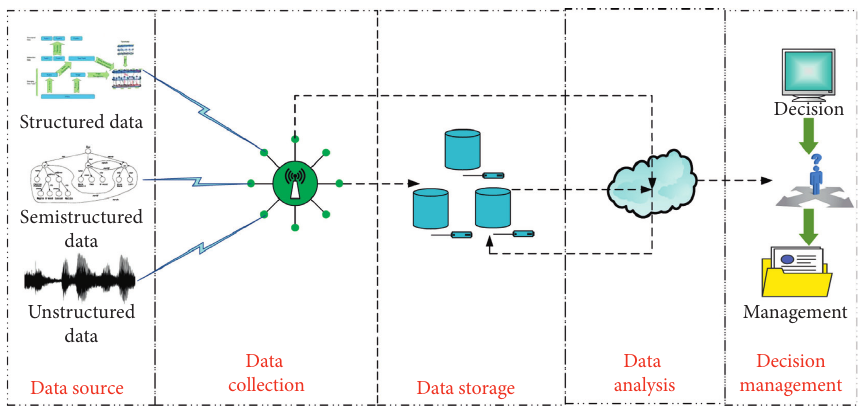
Figure 1: Process chart of data mining and visualization on the cloud